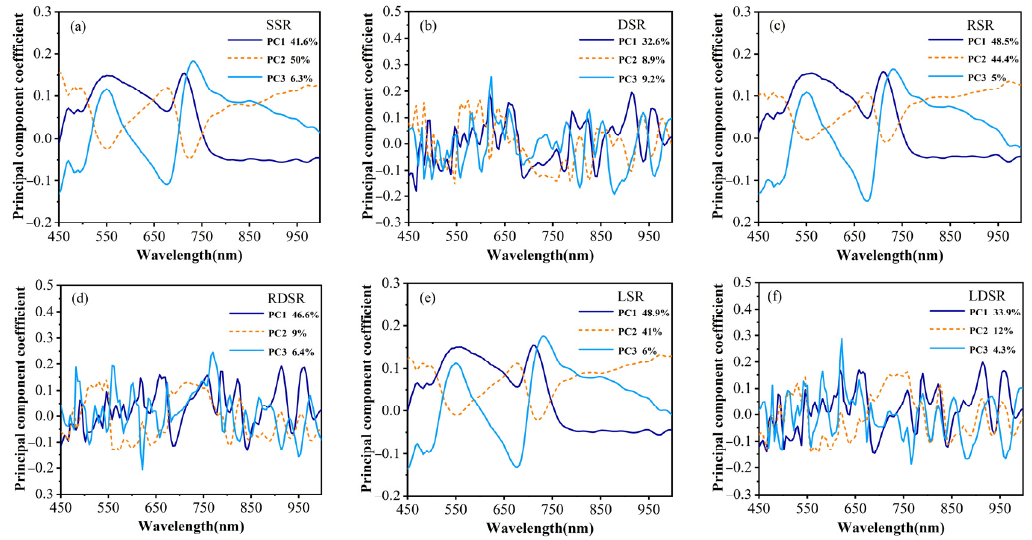
Figure 7. The first three principal components (PCS) of PLSR explained the highest variance ratio of the different spectral regions obtained from the different data sets: ( a ) SSR, ( b ) DSR, ( c ) RSR, ( d ) RDSR, ( e ) LSR, ( f ) LDSR.